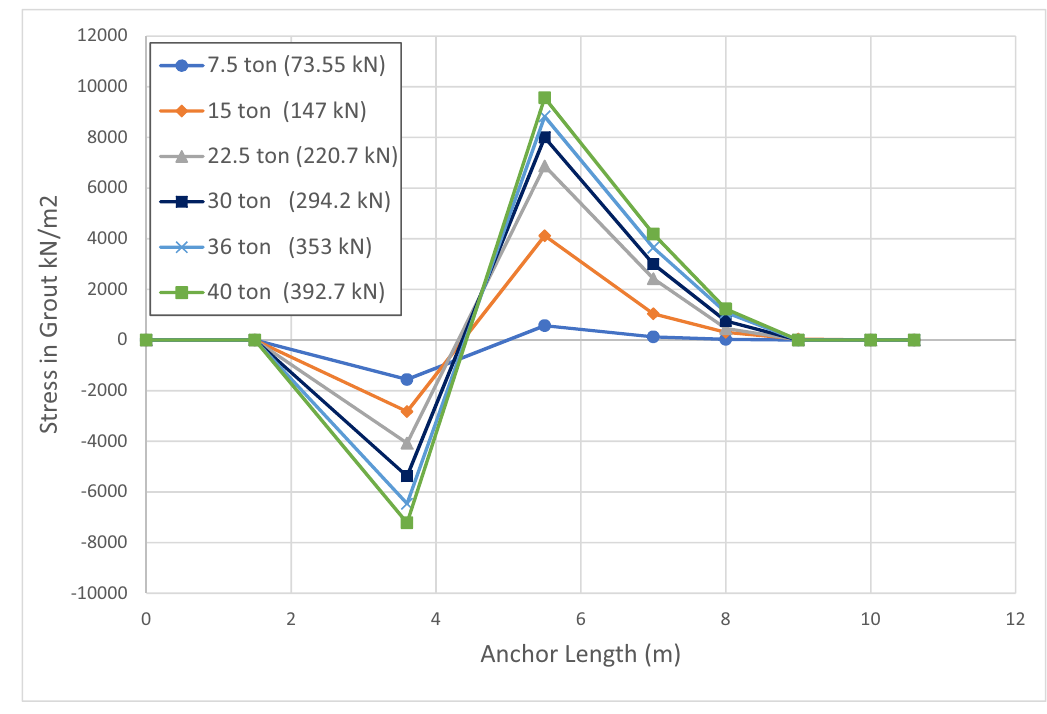
Figure 19: Stresses along the grouted body of anchor 1, starting from the ground surface.